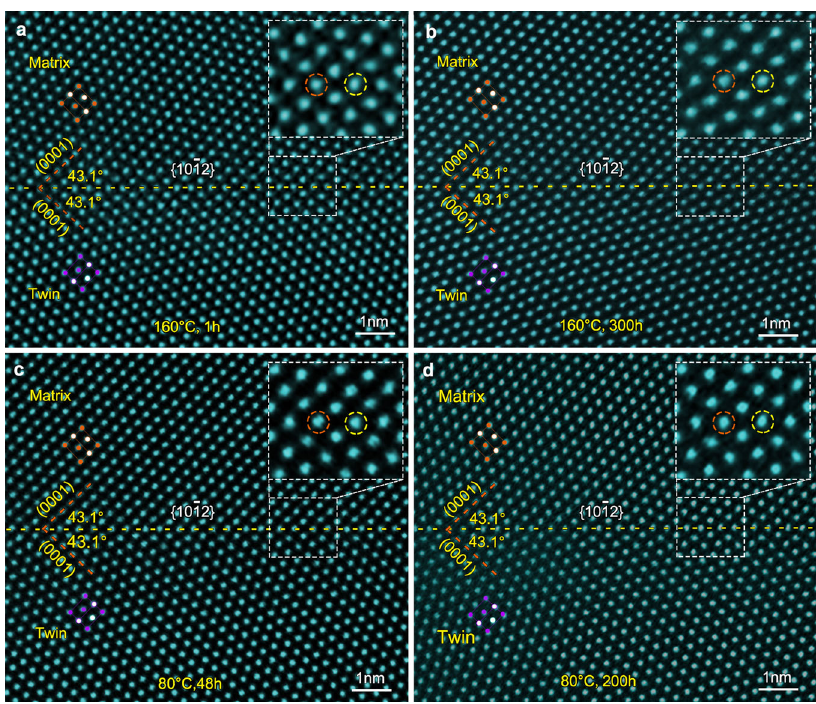
Fig. 2 Absence of apparent segregation of Bi atoms in {1012} CTB. HAADF-STEM images showing {1012} CTBs in Mg – 0.4Bi alloy: a aged at 160 °C for 1 h, b 160 °C for 300 h, c 80 °C for 48 h, and d 80 °C for 200 h. Enlarged images of TBs are shown as insets in the upper-right, revealing that no Bi-rich columns are detected at {1012} CTBs. The alternating compression and extension sites of the CTB are marked by orange and yellow dash-line circles,